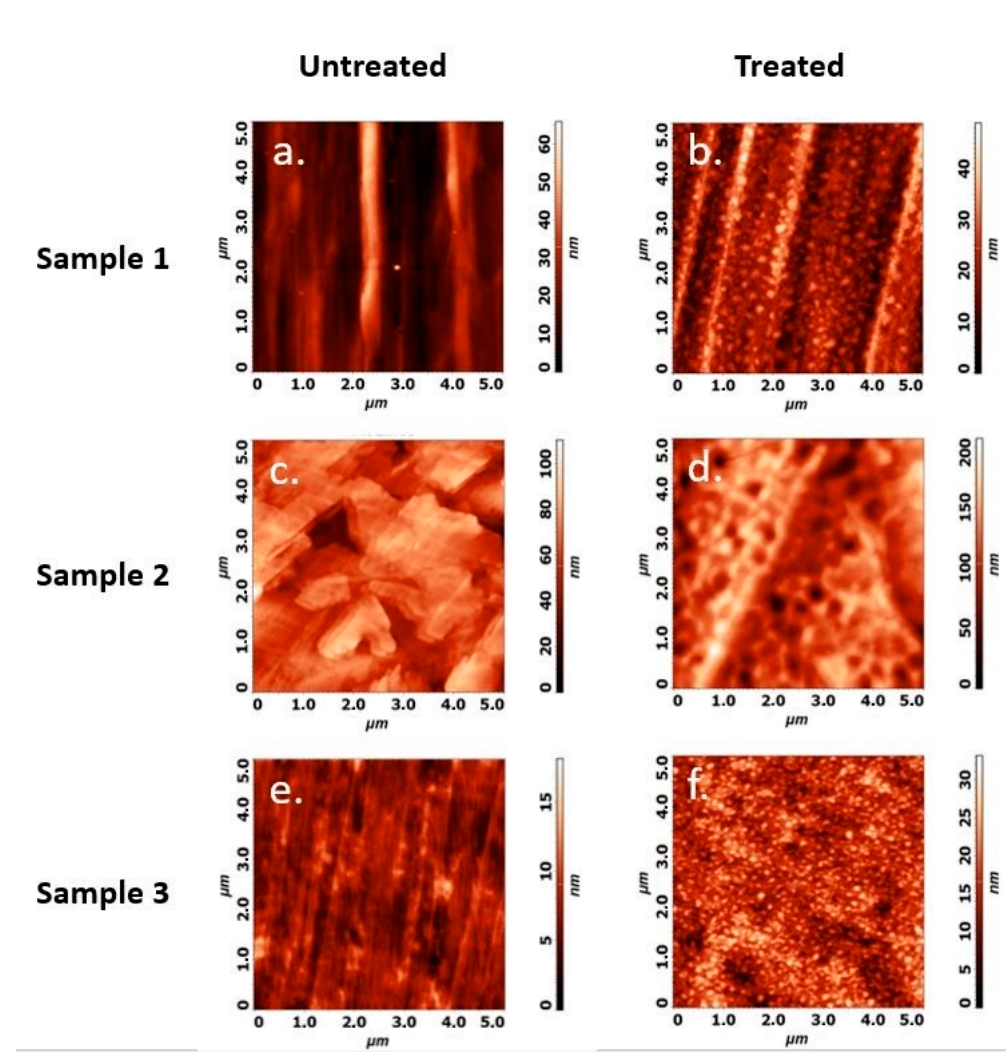
Figure 4. Two-dimensional Atomic Force Microscopy (AFM) images showing gaseous plasma nanostructured surfaces measured on 5 × 5 µm areas. ( a ) untreated sample 1; ( b ) treated sample 1; ( c ) untreated sample 2; ( d ) treated sample 2. ( e ) untreated sample 3; ( f ) treated sample 3.